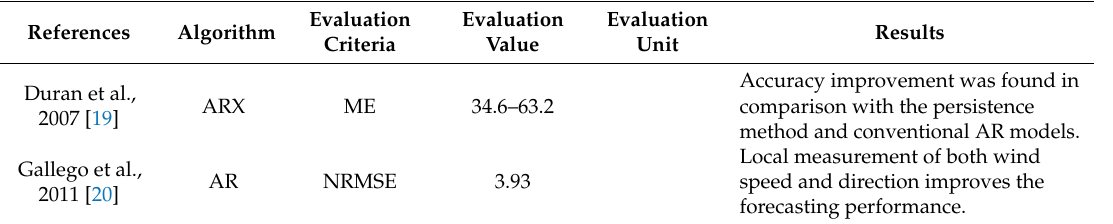
Table 5. Performance evaluation in time series wind power prediction models.